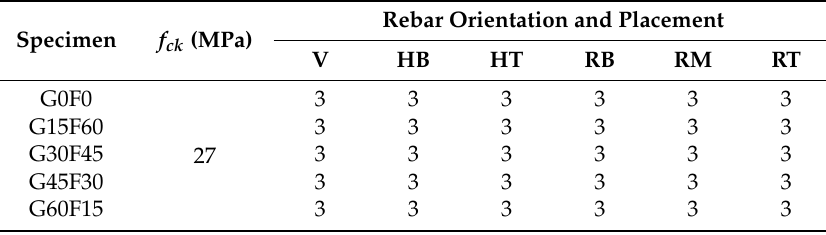
Table 3. Description of test specimens.